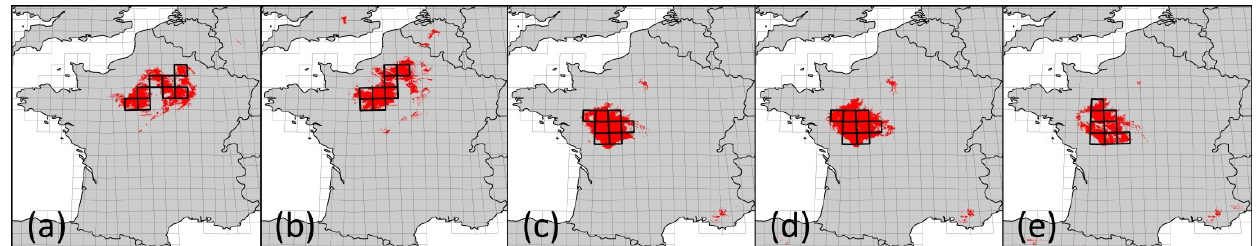
Figure 4. FCARs for species pool comparisons (bold black) and corresponding future climatically analogous Worldclim grid cells (red) ( a ) CLM B1; ( b ) REMO B1; ( c ) REMO A1B run BFG; ( d ) REMO A1B run UBA; ( e ) REMO A2.